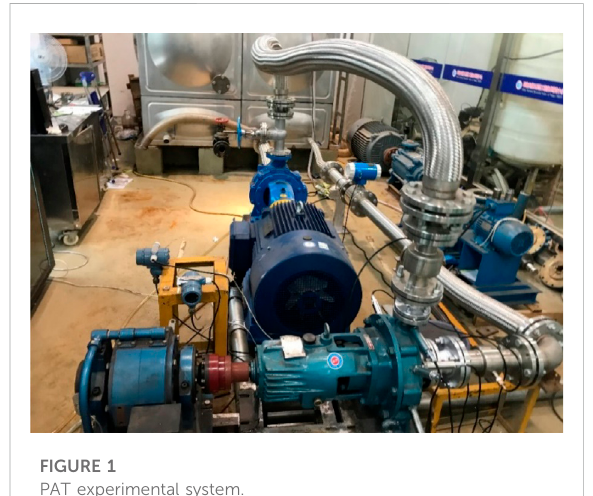
FIGURE 1 PAT experimental system.